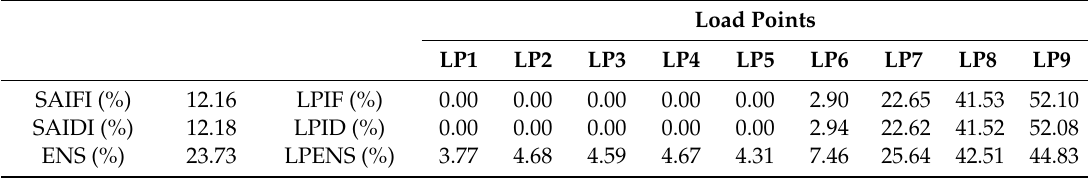
Table 8. Feeder and load point reliability indices improvement for